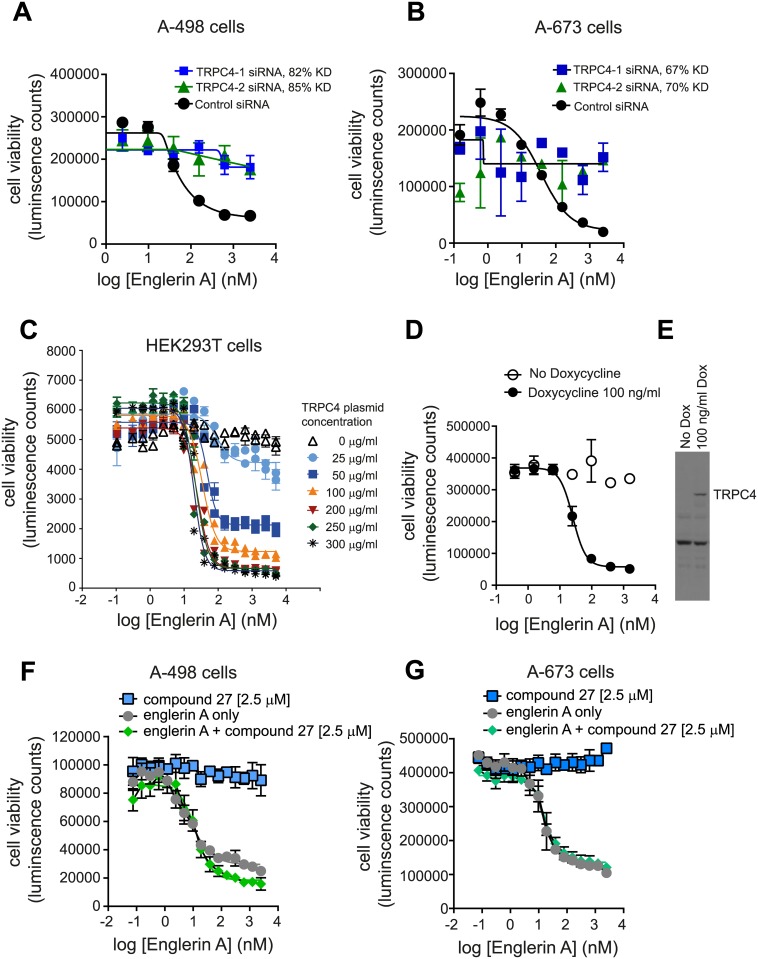
TRPC4 expression is necessary and sufficient for cell proliferation effects of englerin A.
(A) Effect of TRPC4 siRNA knockdown on viability of A-498 cells in the presence of englerin A. An siRNA targeting luciferase was used as a control (mean+/- S.E.M.) Percent reduction of the TRPC4 mRNA levels are indicated in the legend, KD stands for knockdown. TRPC4 mRNA levels were normalized to peptidyl prolyl isomerase A (PPIA) mRNA levels. (B) Effect of TRPC4 siRNA knockdown on viability of A-673 cells in the presence of englerin A (mean +/- S.E.M.) (C) Effect of overexpression of TRPC4 by transient transfection on viability of HEK293T cells in the presence of englerin A. TRPC4 expression vector concentrations are indicated by different shapes (D) Effect of TRPC4 expression on cell viability in the presence of an englerin A in HEK293T cells engineered to express TRPC4 under control of a Doxycycline (Dox) regulated promoter (mean +/- standard deviation). 100 ng/ml Dox (black circles), 0 ng/ml Dox (open circles). (E) Western blot visualizing the levels of TRPC4 in the presence or absence of 100 ng/ml Dox. (F) Effect of PKCtheta inhibitor compound 27 on response to englerin A in A-498 cells. (G) Effect of PKCtheta inhibitor compound 27 on response to englerin A in A-673 cells.